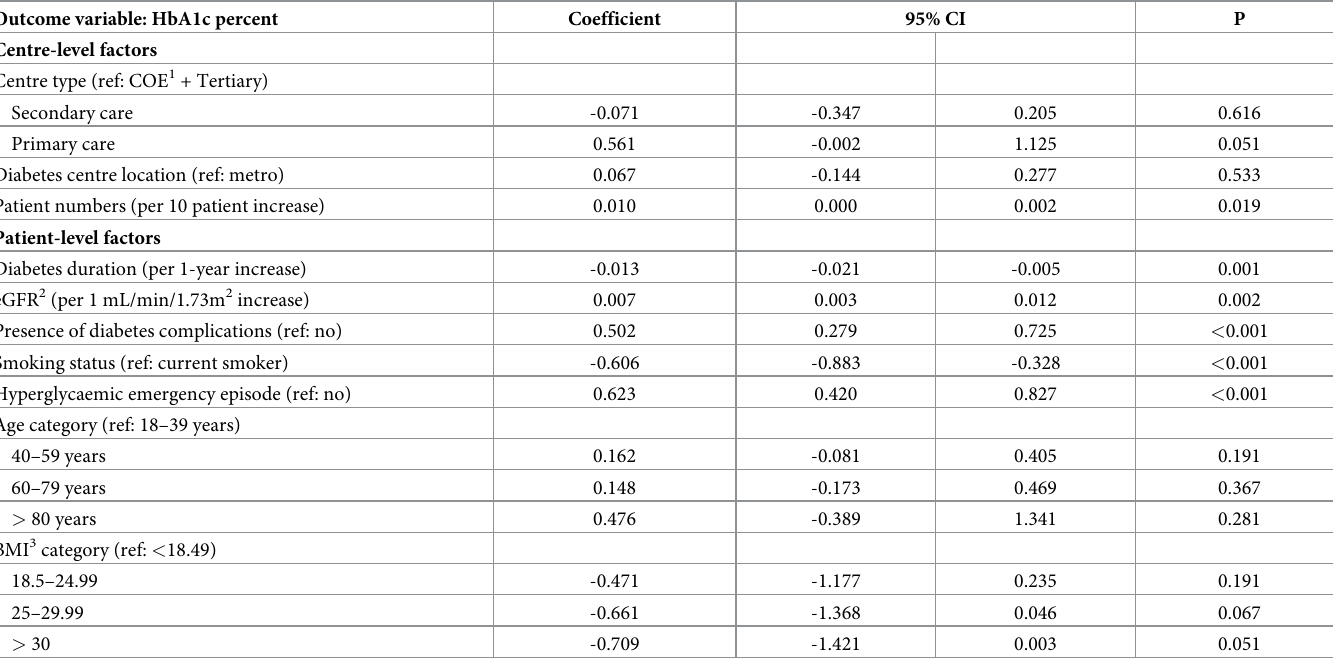
Table 3. Mixed effects multivariate modelling of variation in HbA1c, type 1 diabetes.